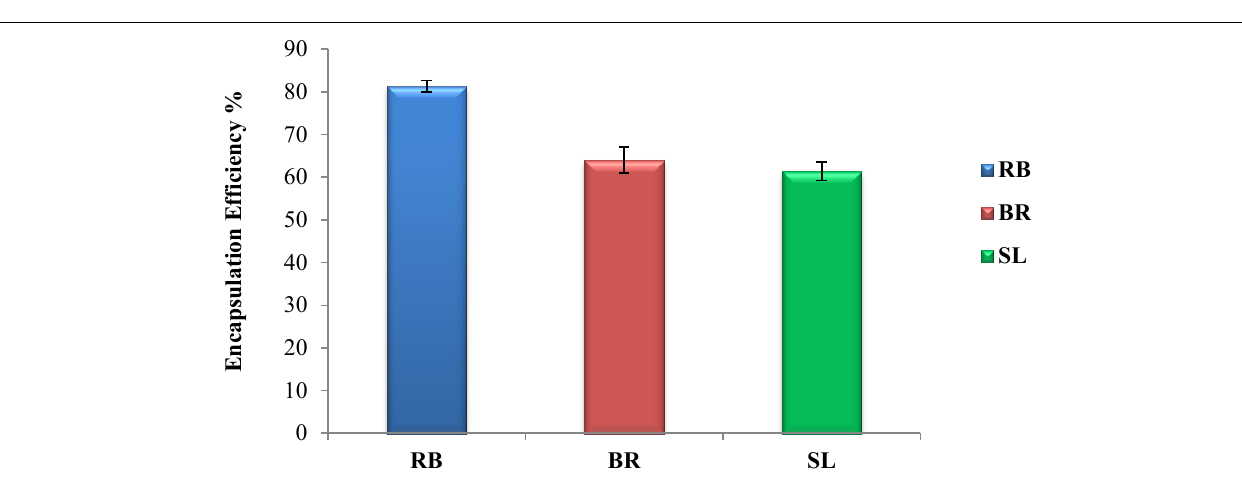
compounds were strategically placed near the peptide side chain groups. The active groups para-OH (p-OH), meta-OH (m-OH), and COOH of phenolics are postulated to act as hydrogen bond donors/acceptors for various amino acid side chain groups